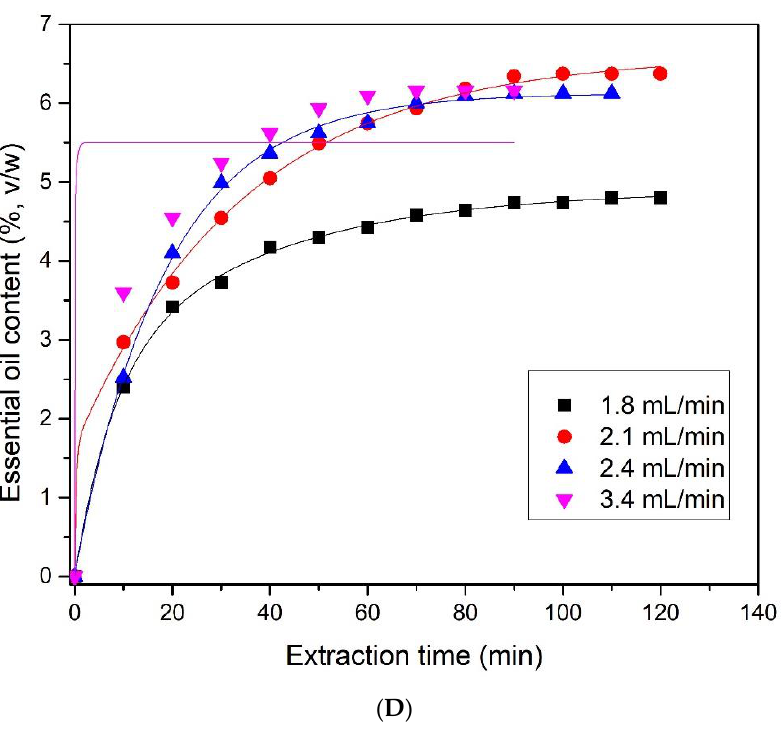
Figure 6. Kinetic model of steam distillation at different steam flow rates with ( A ): model 1; ( B ): model 2; ( C ): model 3; ( D ): model 4.